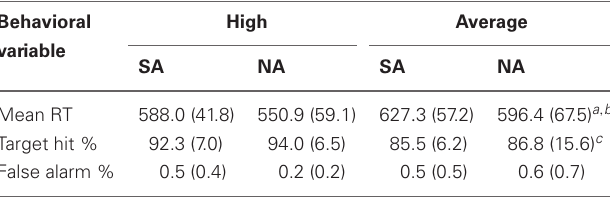
Table 2 | Mean RT and accuracy for SA and NA tasks [mean (SD)].